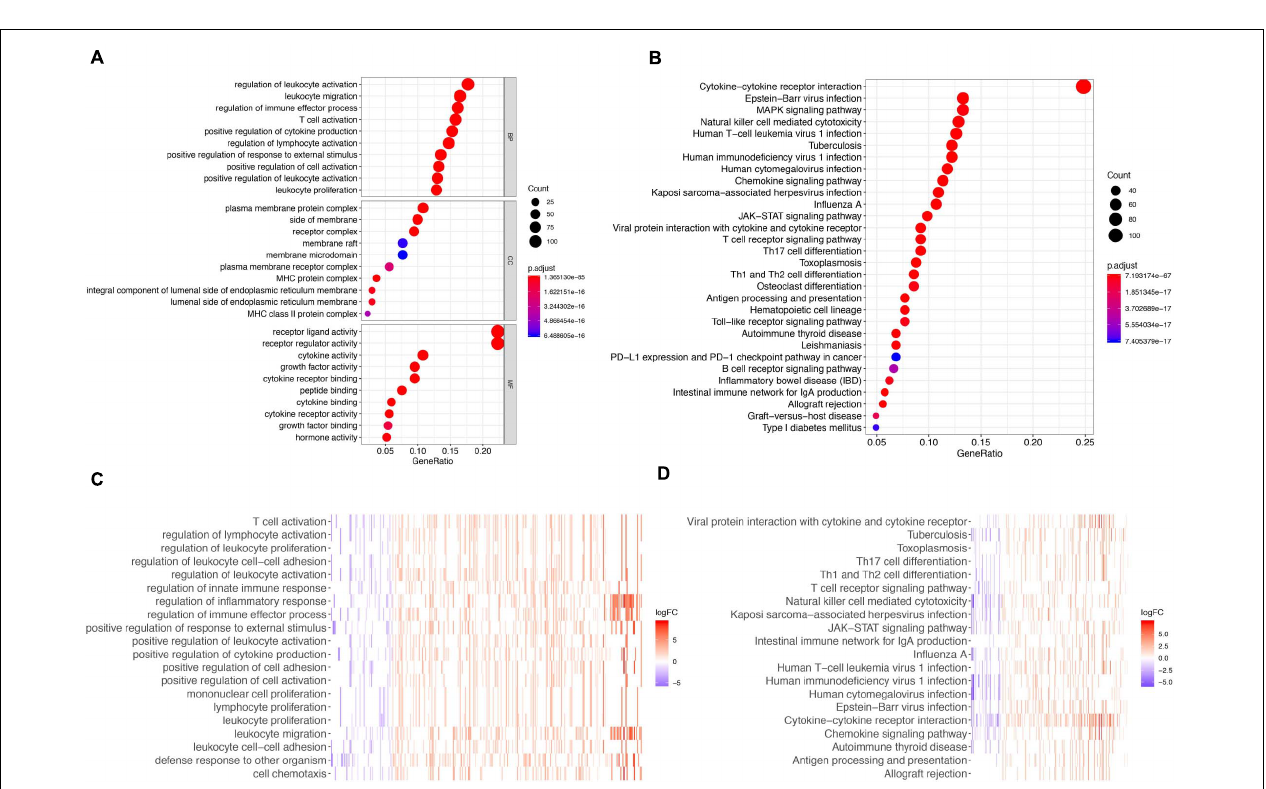
FIGURE 1 | Identification of differentially expressed IRGs between GBM and normal brain tissues. (A) Volcano plots showing the log 2 (fold change) of mRNA in GBM compared to normal brain tissues, and the corresponding-log 10 ( P value) in TCGA datasets. Genes with adjusted P value below 0.05 and fold change above one (below –1) were marked with red (green) dots. (B) Heatmap of the differentially expressed IRGs in TCGA datasets.